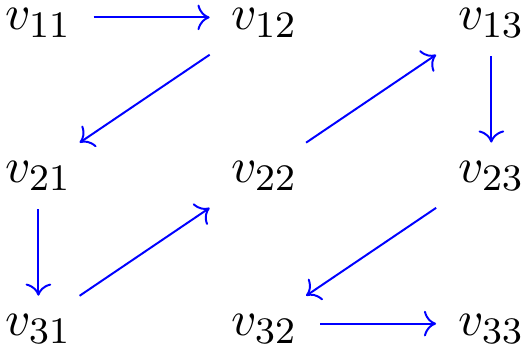
3 patch × 3 patch matrix. ×